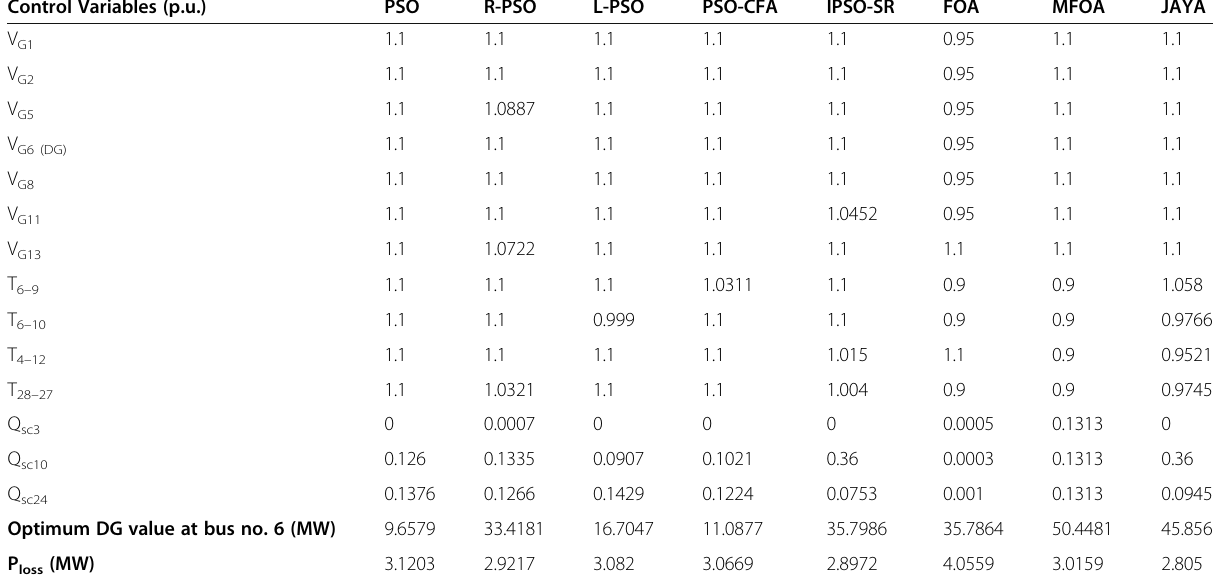
Table 18 Simulation results on the IEEE 30 bus system with underestimated Weibull probability distribution function of wind power on ORPD using different algorithms Control Variables (p.u.)